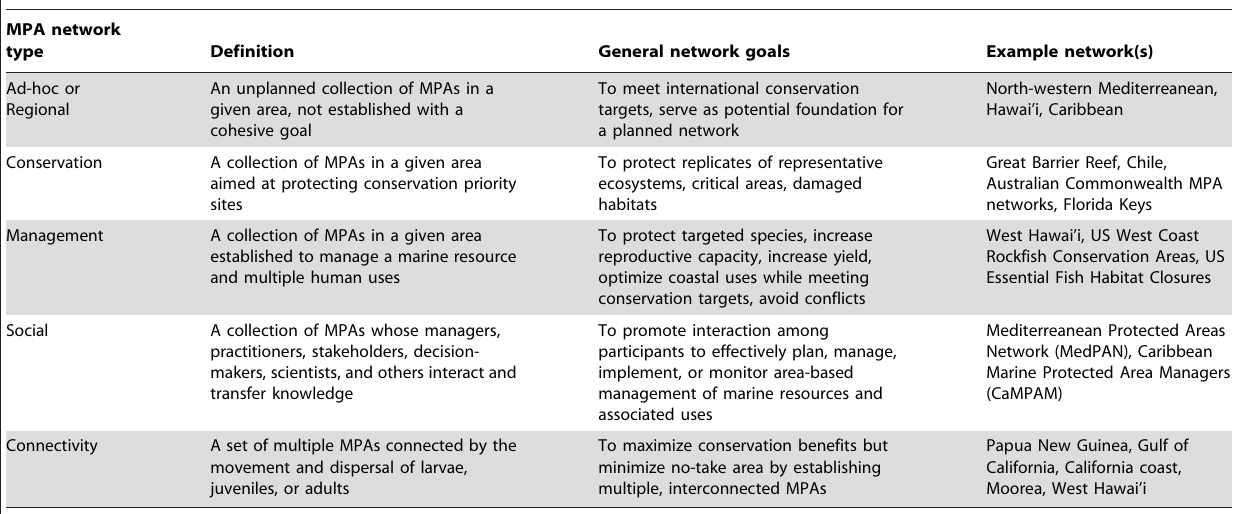
Table 1. Definitions, goals, and examples for each type of marine protected area (MPA)